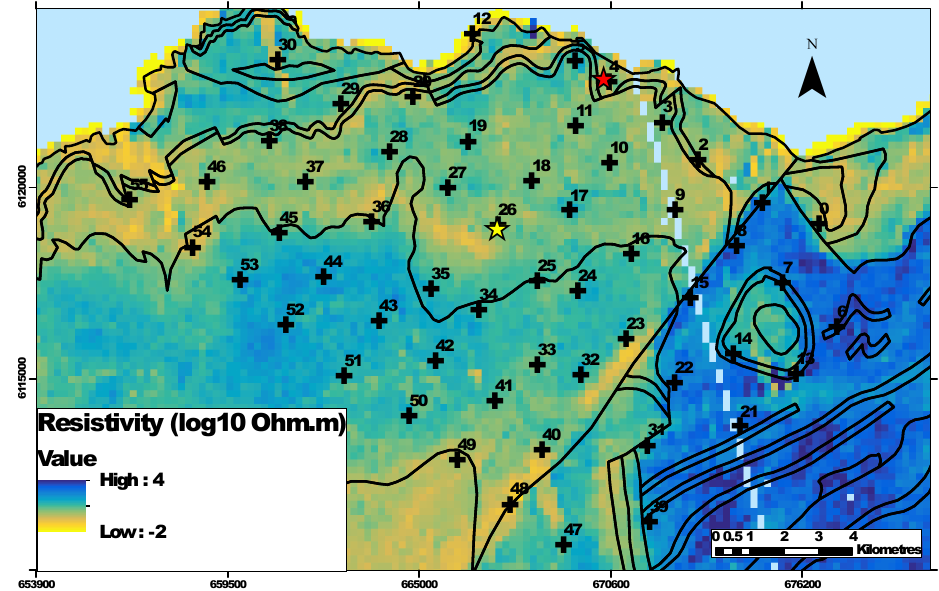
Figure 6. Map of airborne FDEM half-space resistivity models, overlain with geological boundaries (solid black lines, as in Fig. 1) and MT site locations (black cross symbols). The model exhibits good correlation with the mapped boundaries, as well as variation within each geological unit. Note that data from one flight line are missing, resulting in a pale dashed line in the figure. These absences were interpolated across in the synthetic model.